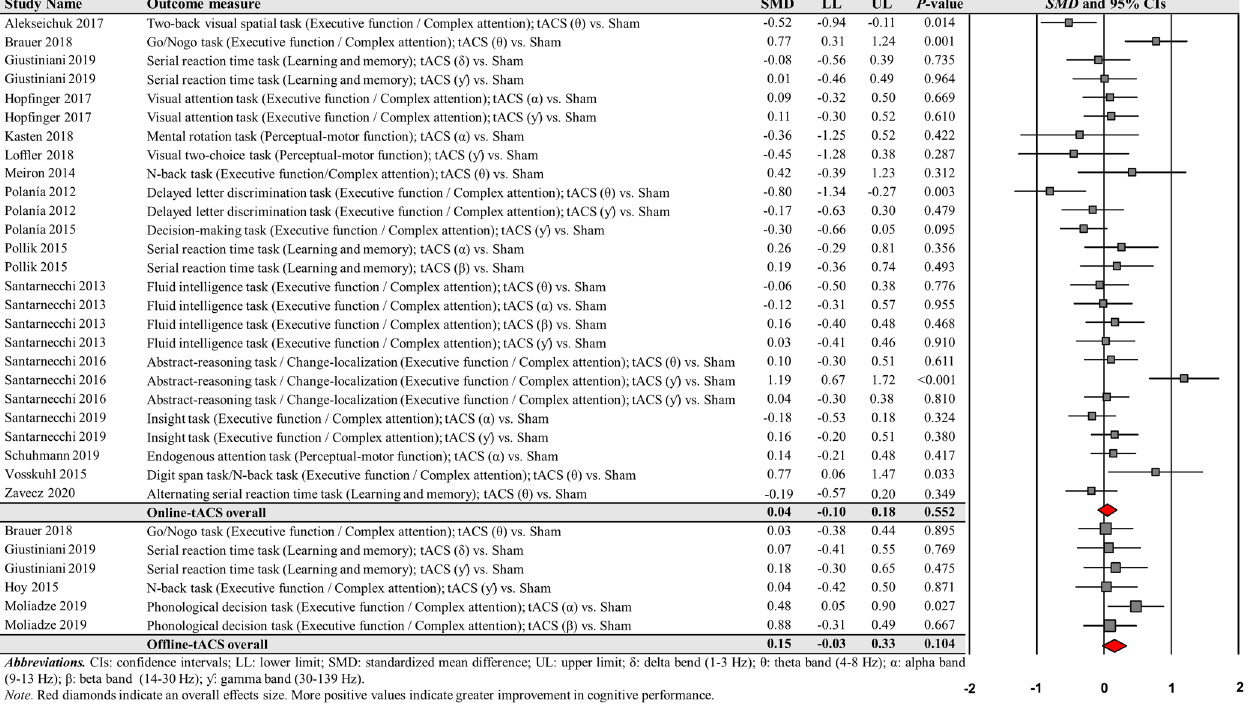
Fig. 11 Cognition-related reaction time comparisons after online- and of fl ine-tACS. Meta-analytic fi ndings show no signi fi cant effects of online- and of fl ine-tACS protocols on changes in cognition-related reaction